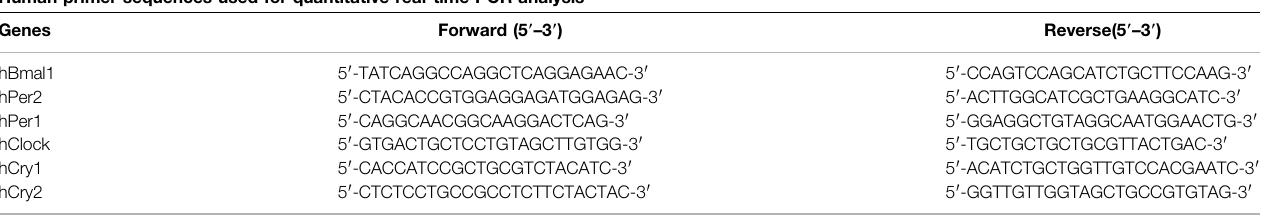
TABLE 1 | Primer sequences used for quantitative RT-PCR analysis. Human primer sequences used for quantitative real-time PCR analysis